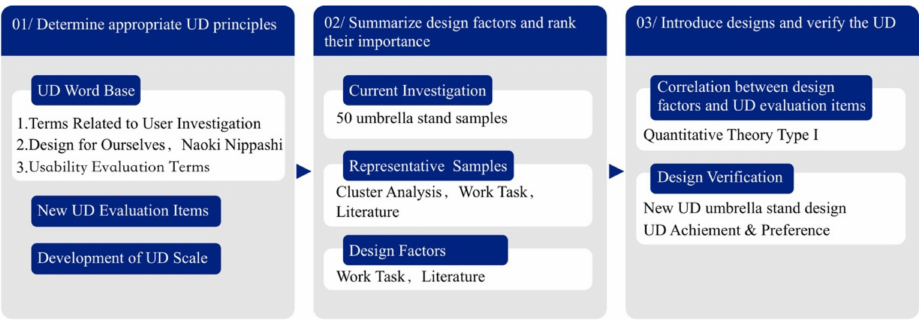
Figure 1. Research methods and experimental